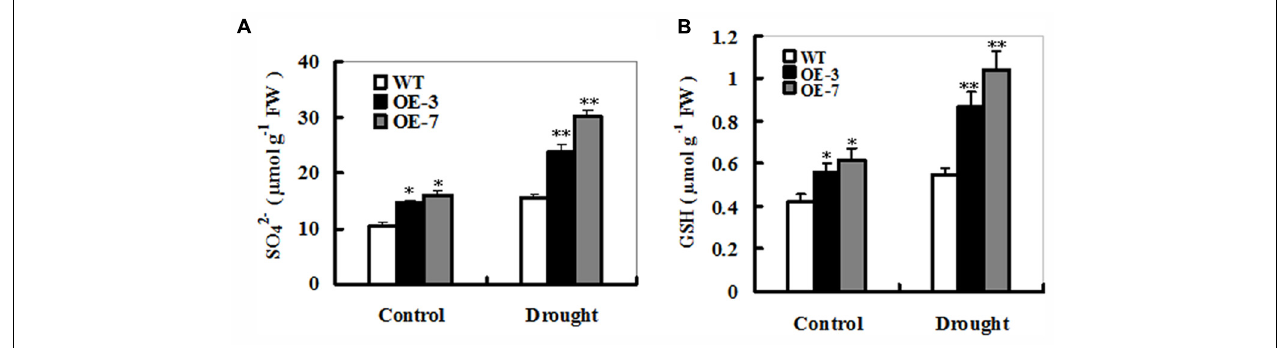
FIGURE 5 | Sulfate and glutathione accumulations in the WT and ZmSO -overexpressing tobacco plants under drought stress. Contents of sulfate (A) and GSH (B) were measured in leaves of WT and both OE lines (OE-3 and OE-7) after 9-day drought stress. Each experiment was repeated three times. Bar indicates SE. Values are mean ± SE. ∗∗ t -test, with P < 0.01; ∗ t -test, with P < 0.05.